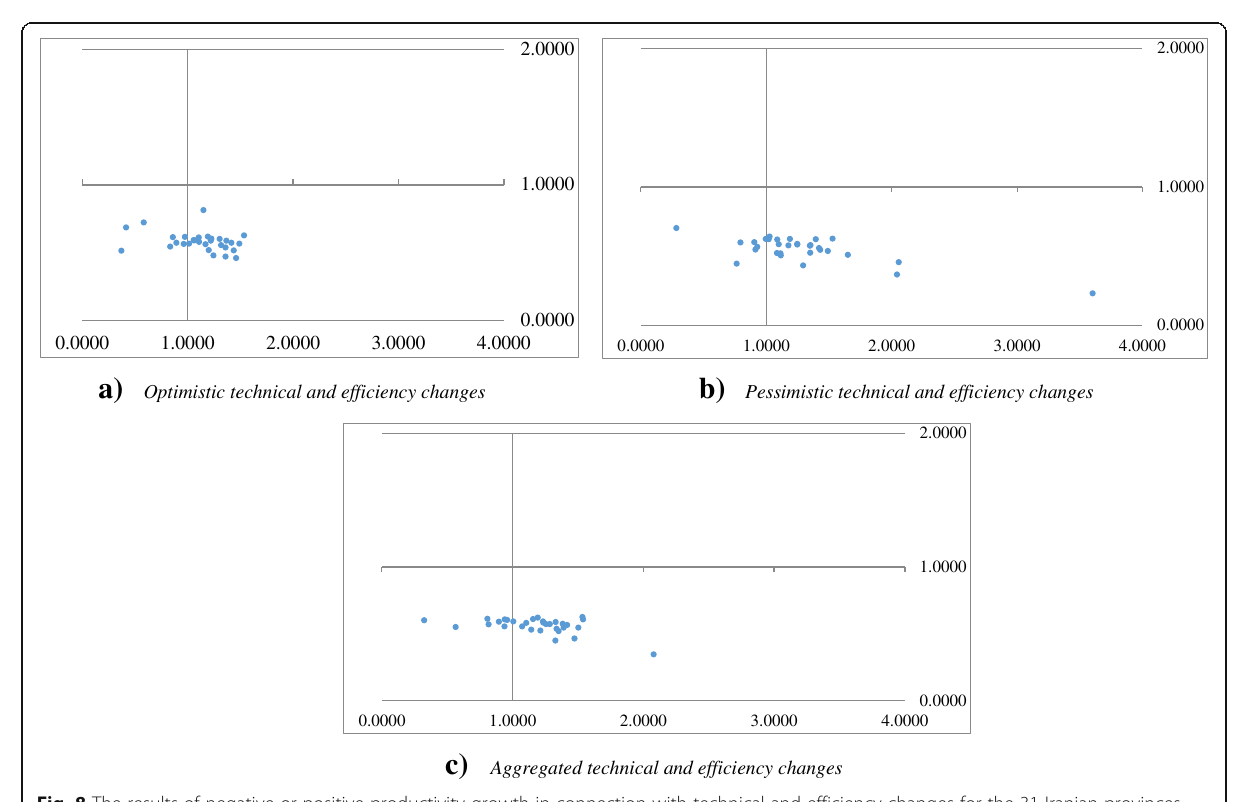
Fig. 8 The results of negative or positive productivity growth in connection with technical and efficiency changes for the 31 Iranian provinces from 2015 – 2016. Vertical axes: efficiency change. Horizontal axes: technical